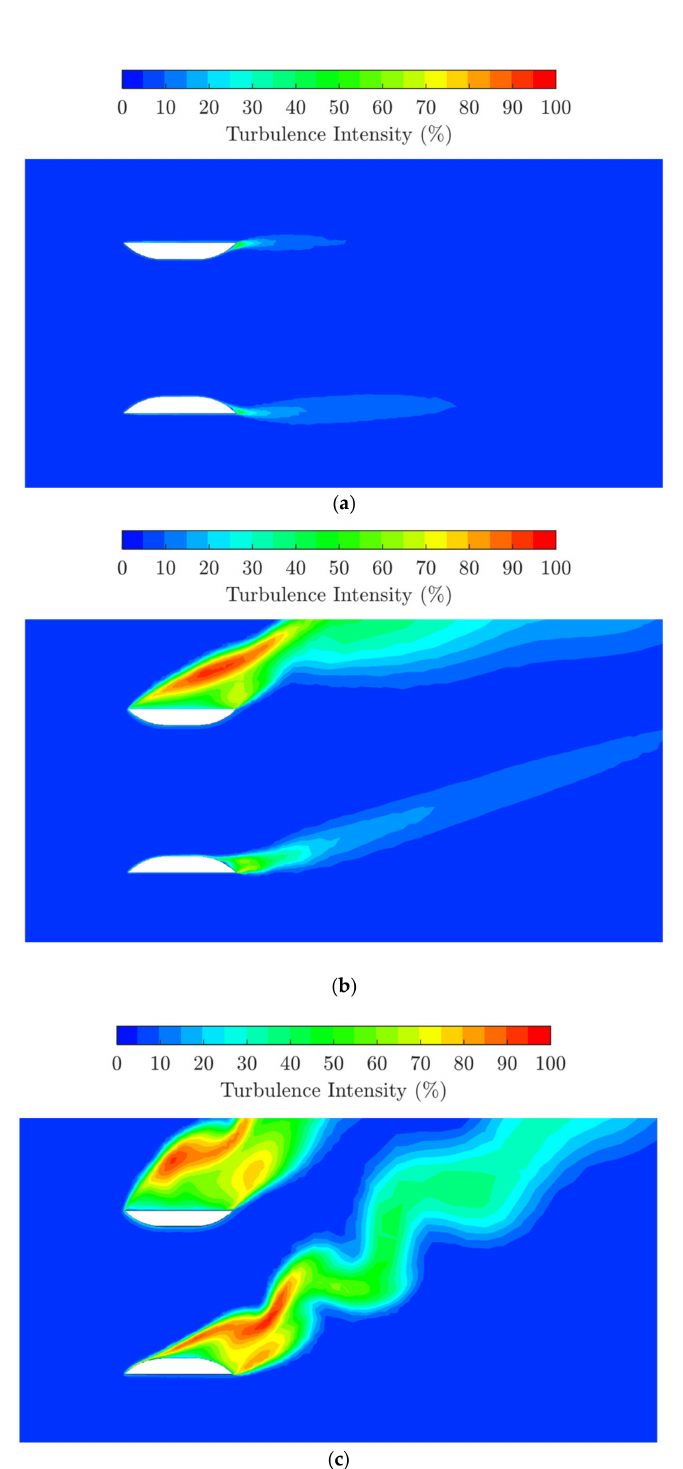
Figure 13. Illustrative cross-sectional representation of the turbulence intensity within the duct domain at distinct yaw angles ( U ∞ = 4 m.s − 1 ). ( a ) γ = 0 ◦ ; ( b ) γ = 23.2 ◦ ; ( c ) γ = 38 ◦